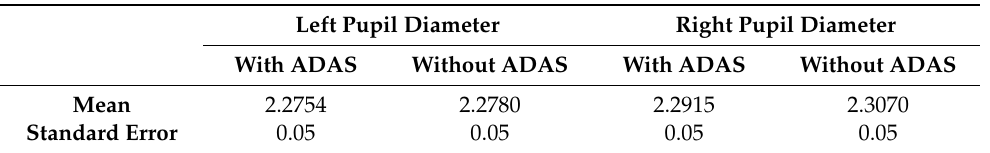
Table 5. Mean and standard error of left and right pupil diameter during merging with and without the assistance